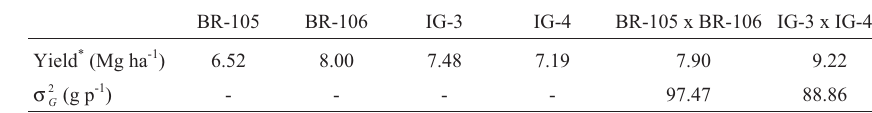
2 ) for the original (BR-105 and BR-106) and selected (IG-3 and IG-4) maize interpopulations 1 Table 6 - Yield and genetic variance ( σ G